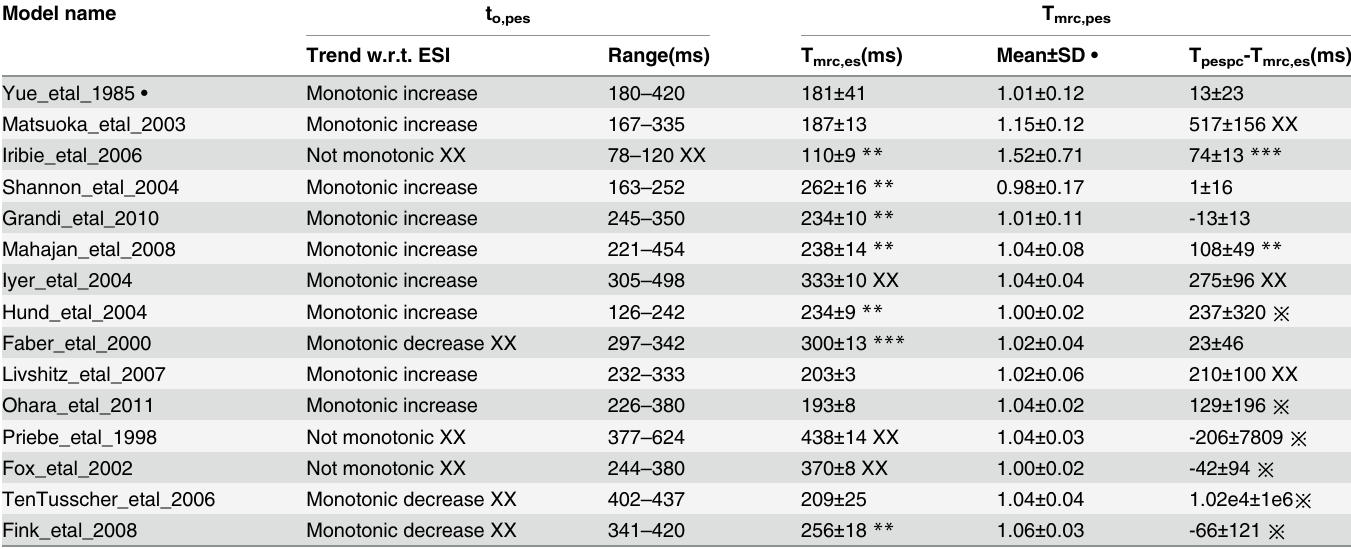
Table 9. Contraction parameters: t o,pes and T mrc,pes . Model